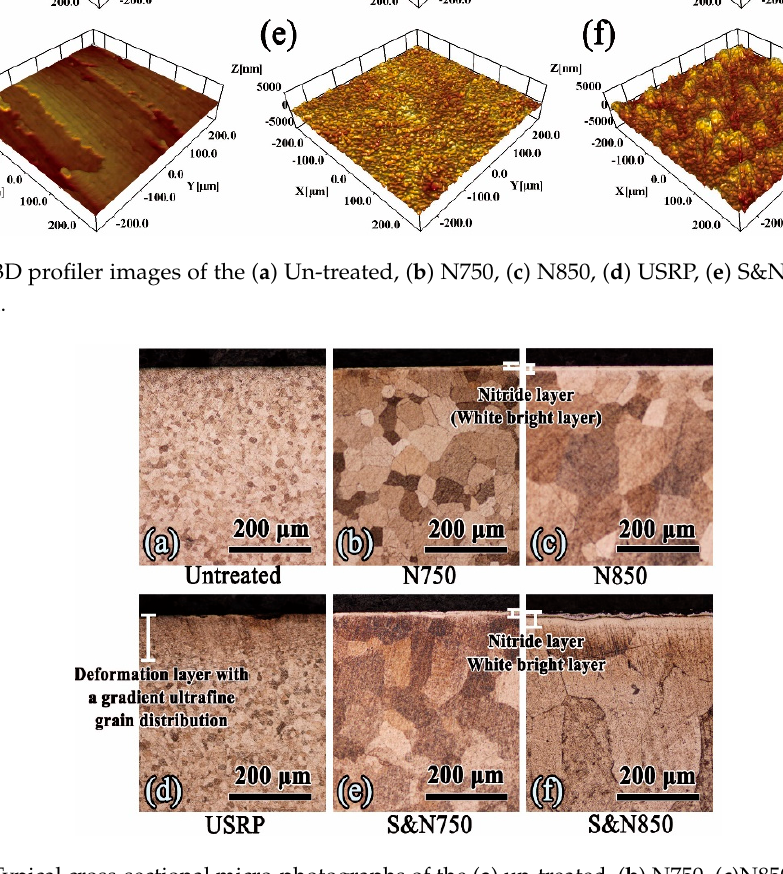
Figure 5. Typical cross-sectional micro-photographs of the ( a ) un-treated, ( b ) N750, ( c )N850, ( d ) USRP, ( e ) S&N750 and ( f ) S&N850 Ti.